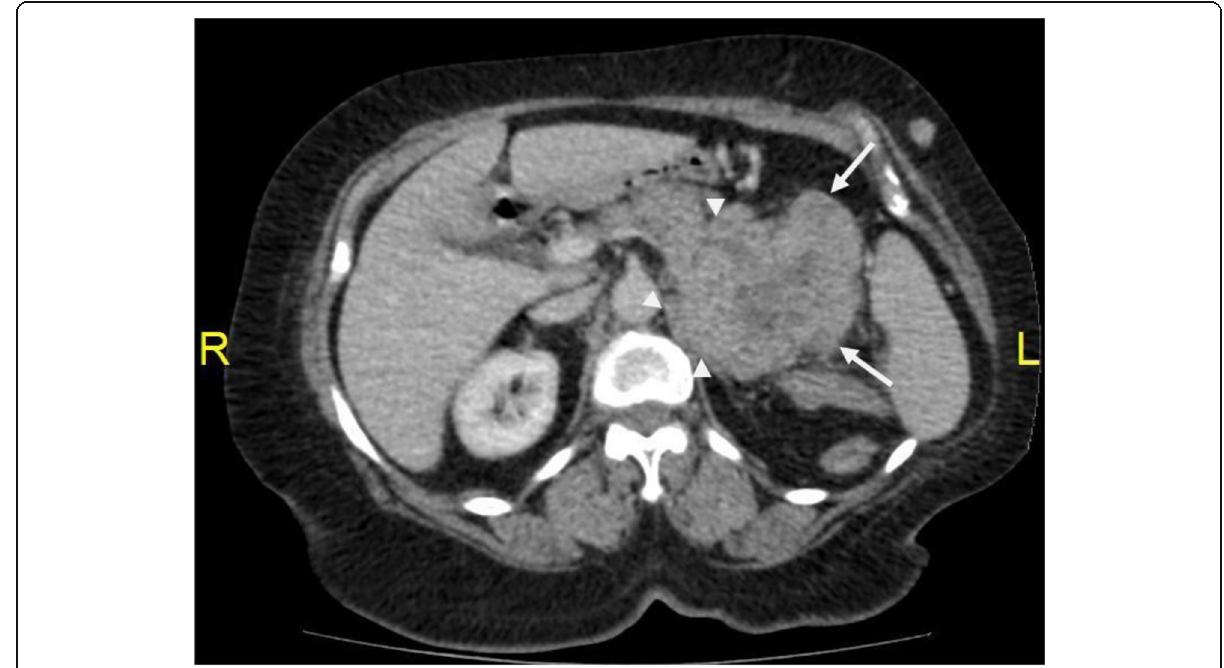
Fig. 1 Contrast-enhanced CT scan of the abdomen showing large ill-defined soft tissue mass arising from the body and lateral limb of left suprarenal gland (arrows), and the mass exhibits heterogeneous postcontrast enhancement with areas of cystic degeneration, and it was seen inseparable from the body and tail of the pancreas as well as the left diaphragmatic crus (arrow